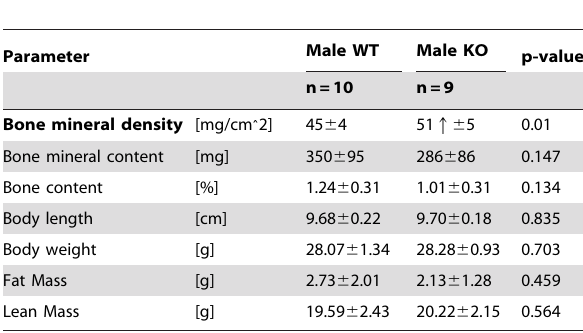
Table 3. Overall body and bone parameters in NM1 knock- out and wild type